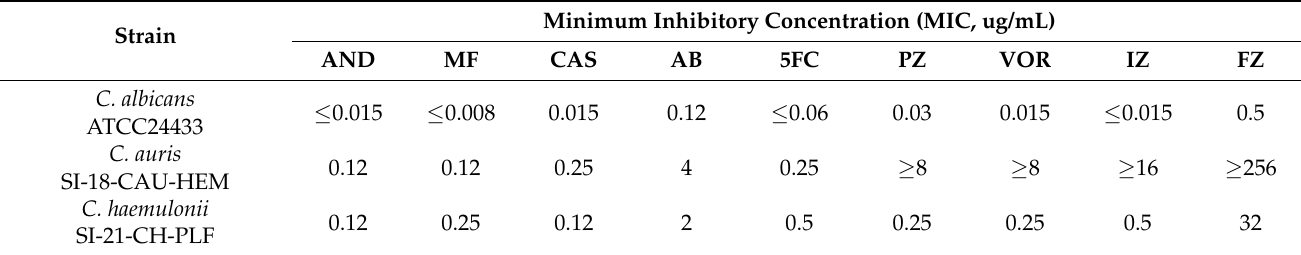
Table 1. Antifungal susceptibility test results of the C. albicans (control strain), C. auris , and C. haemulonii strains. Strain